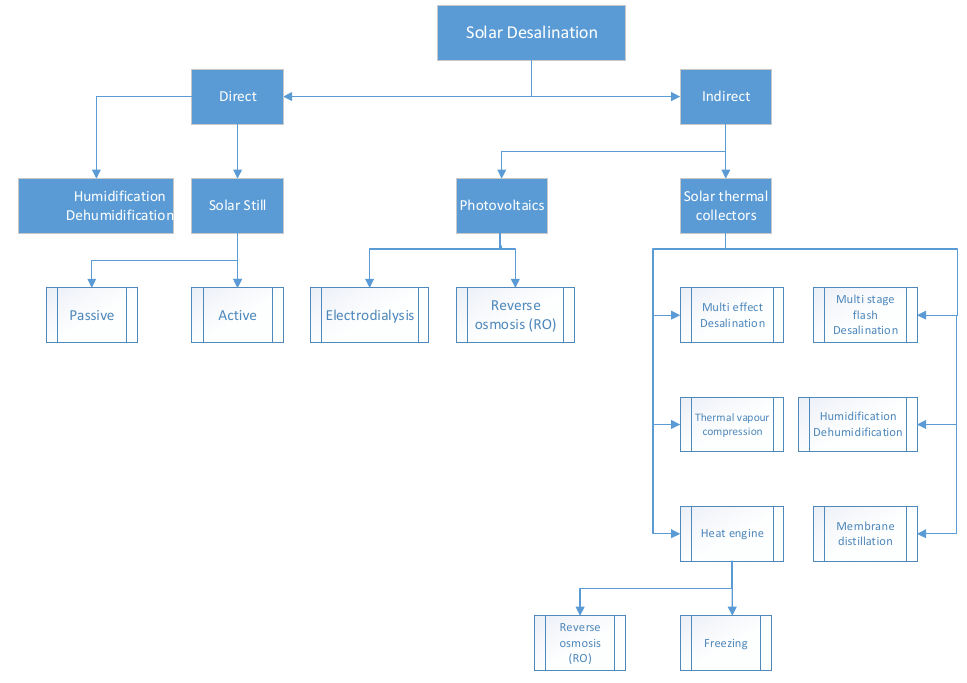
Figure 2. Classification of desalination processes based on solar energy. Table 1. Merits and demerits of various solar desalination